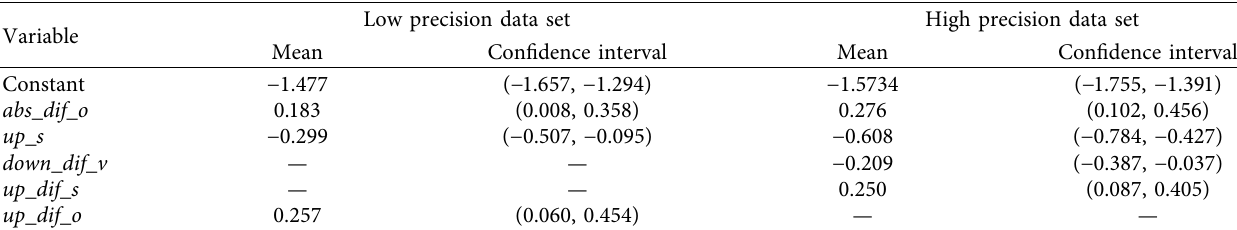
Table 4: Significant risk factors and parameter estimates for the two data sets models.